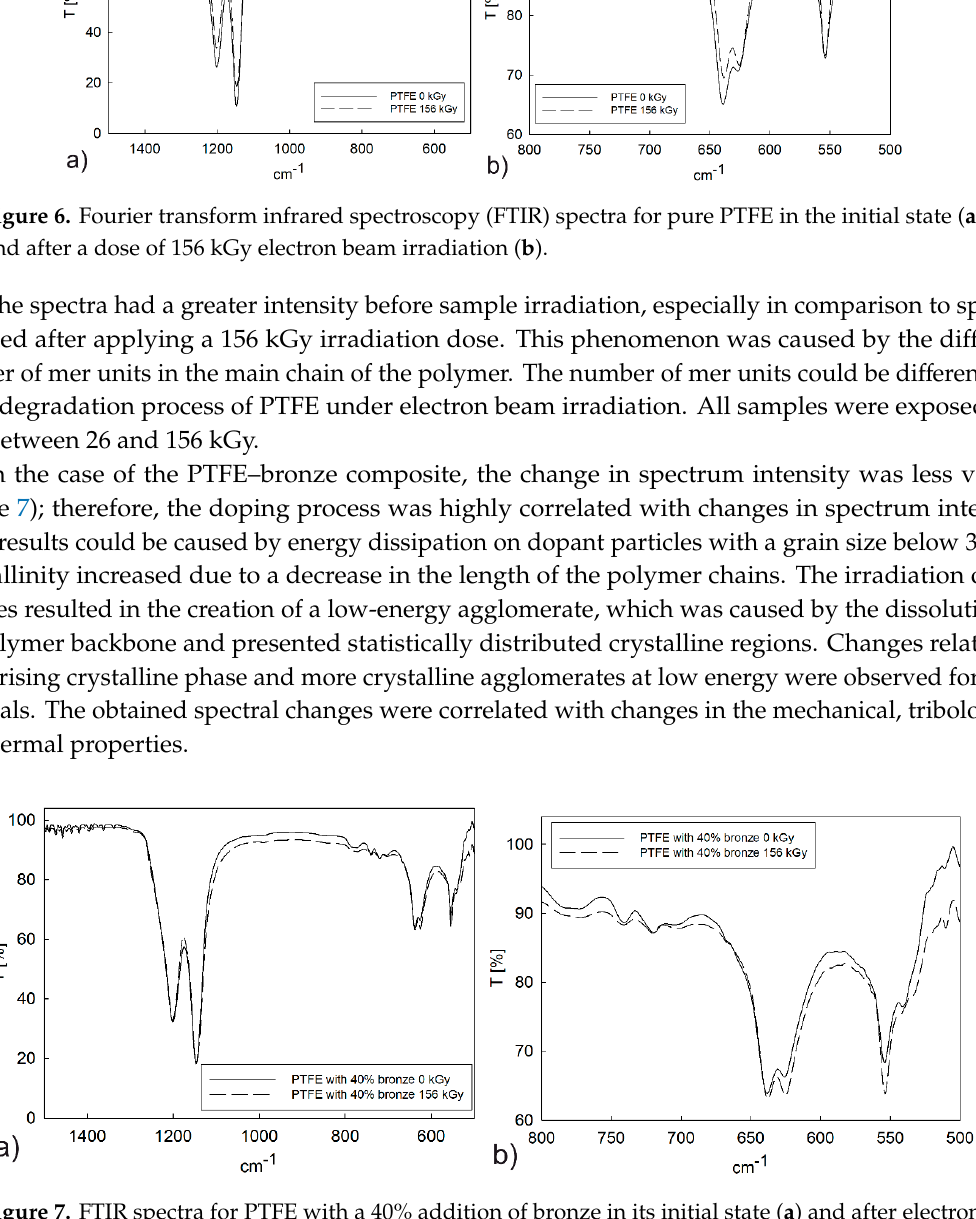
Figure 7. FTIR spectra for PTFE with a 40% addition of bronze in its initial state ( a ) and after electron beam irradiation with a dose of 156 kGy ( b ).